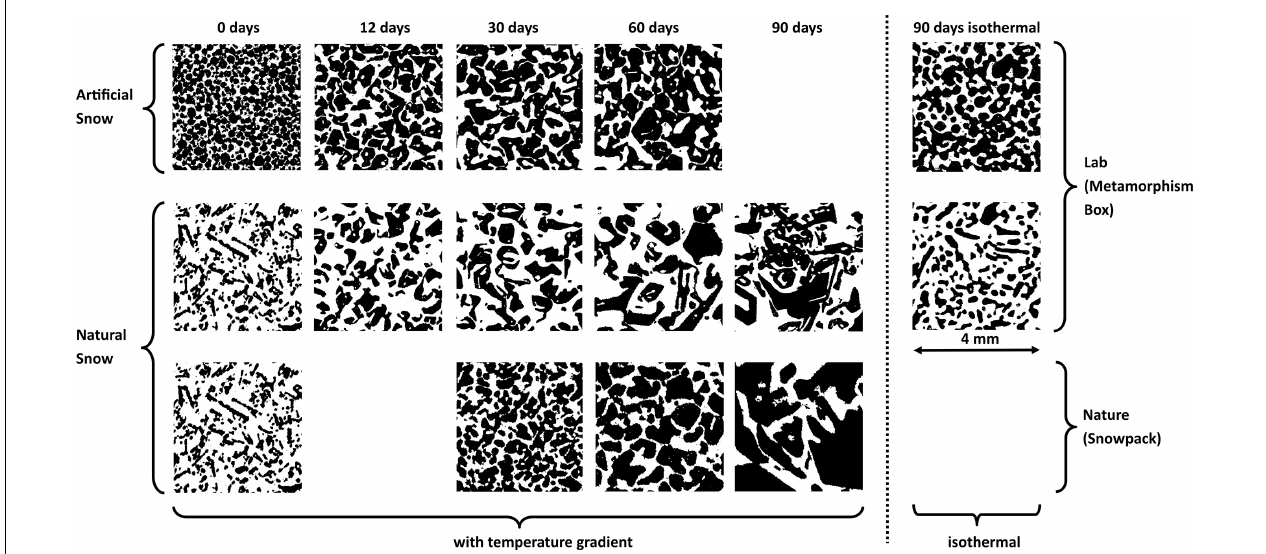
FIGURE 2 | Structural development of the snow samples during metamorphism imaged by microCT. Solid ice is black, interstitial air white. Cross-sections are shown for artificial snow (upper row) and natural snow (middle row) after 0, 12, 30, 60, and 90 days of storage under an artificial gradient of 40 K/m and 90 days isothermal storage at –20 ◦ C. In the lower row cross-sections of 0, 30, 60, and 90 day old snow from different depths of the snow pit at WFJ are shown. These 4 samples originate from 4 different snowfall events at different stages in natural metamorphism.